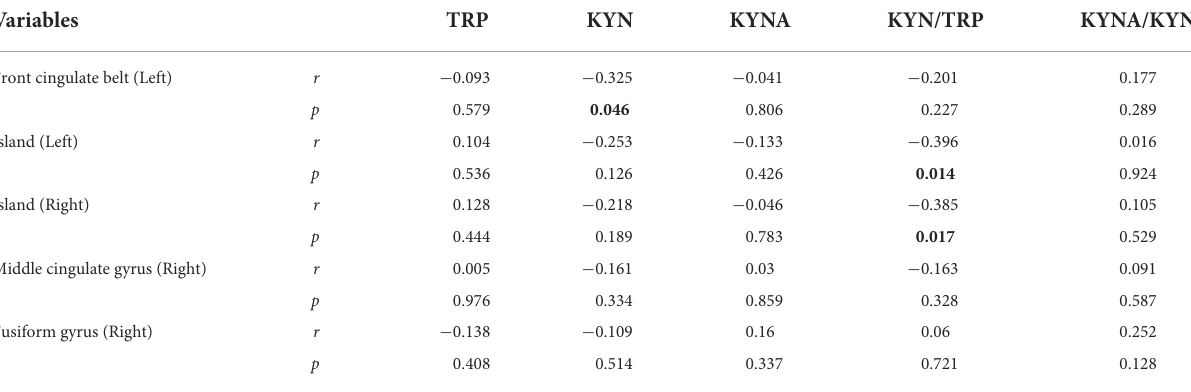
TABLE 4 The Correlation between KM and GMV in